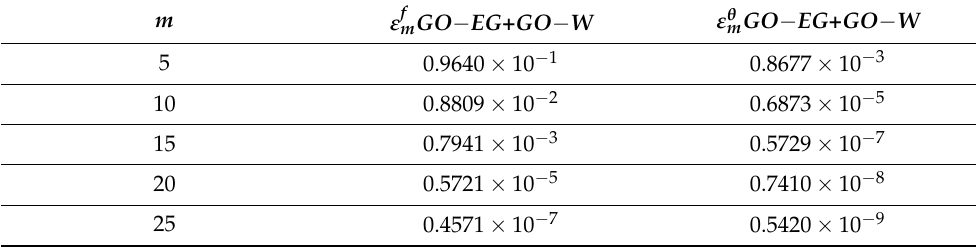
Table 5. Convergence of the method for GO − EG + GO − W .